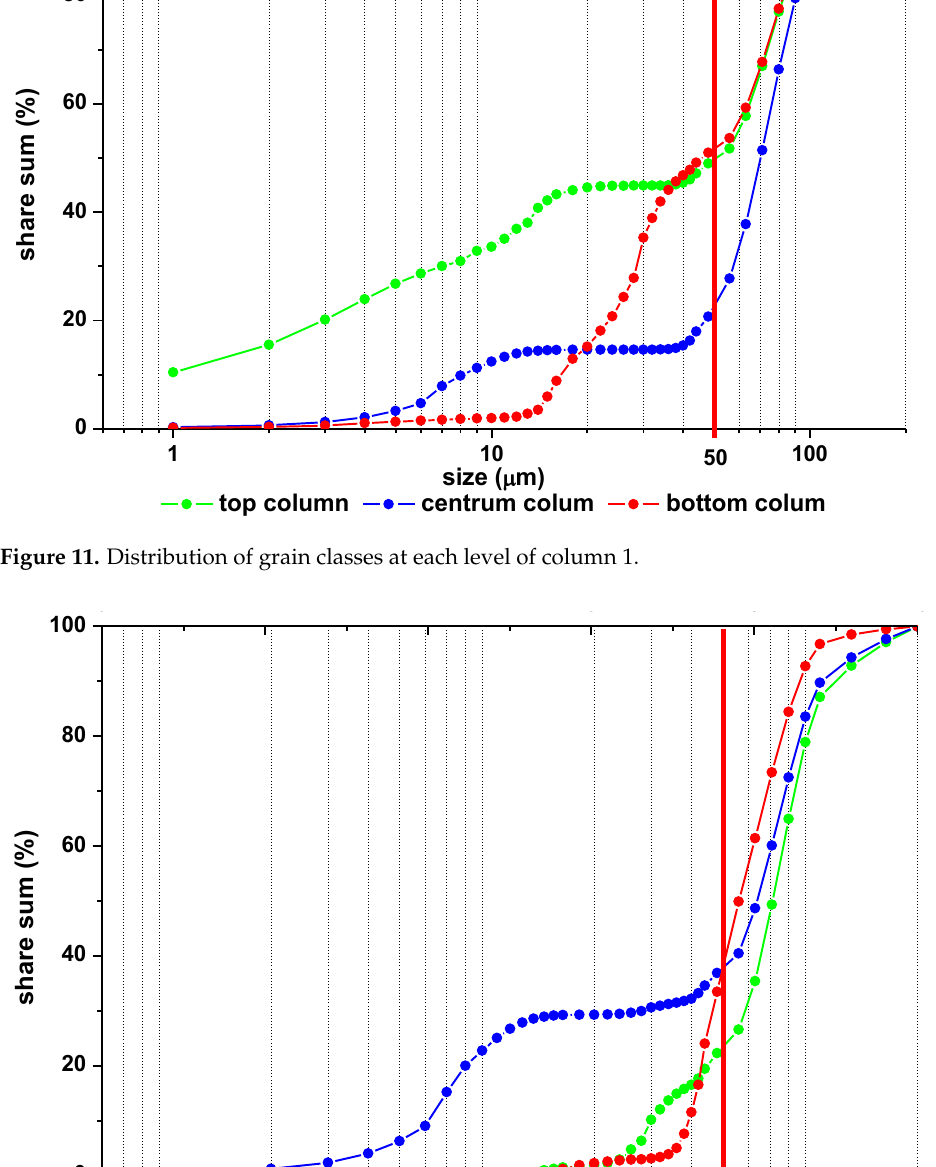
Figure 13. Distribution of grain classes at each level of column 6.